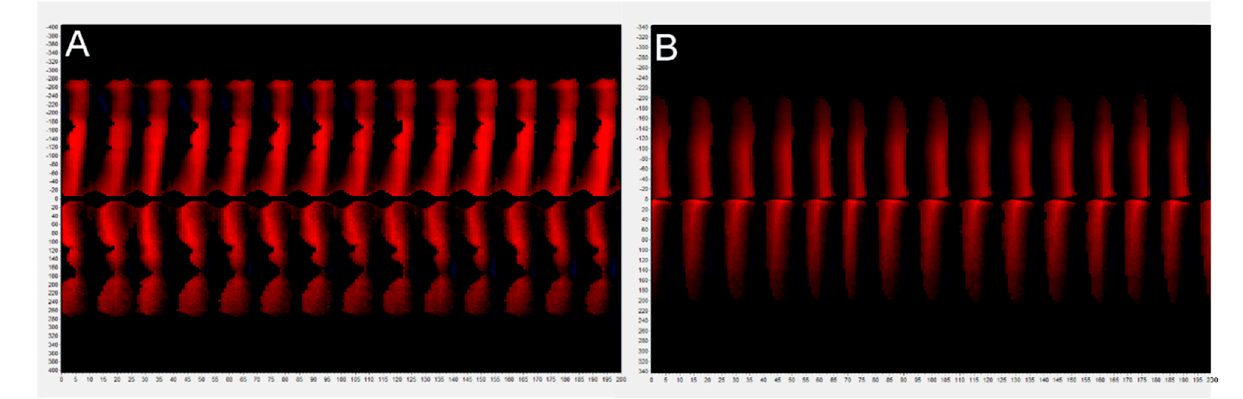
Figure 4. Phonovibrogram generated ( A )-before treatment, ( B )-after treatment. Graph presents the phonatory oscillation of vocal folds. Table 1. Parameters describing abnormalities in frequency and amplitude of phonatory vibrations calculated on the basis of kymograms from HSV